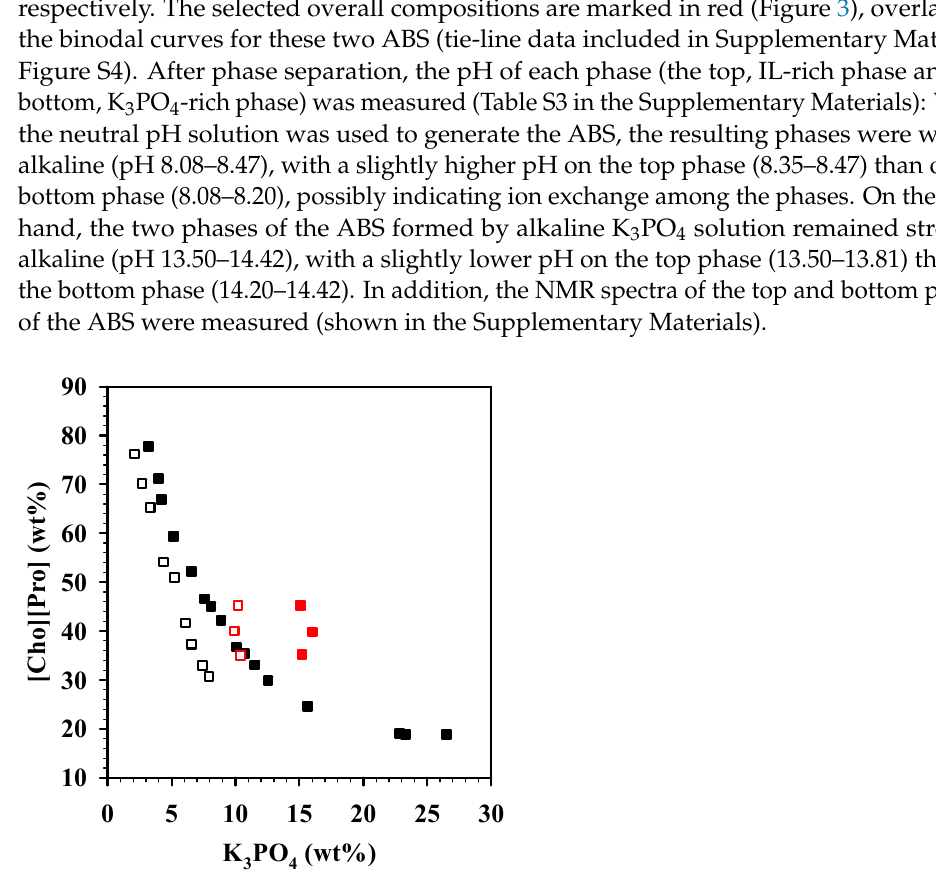
Figure 3. Binodal curves for [Cho][Pro]/K 3 PO 4 ABS (shown in wt%; compare with Figure 1) at pH 7.2 (open symbols) and 14.5 (filled symbols) with the overall compositions used for the NMR study (red symbols). Tie-line data is included in Supplementary Materials Figure S4.